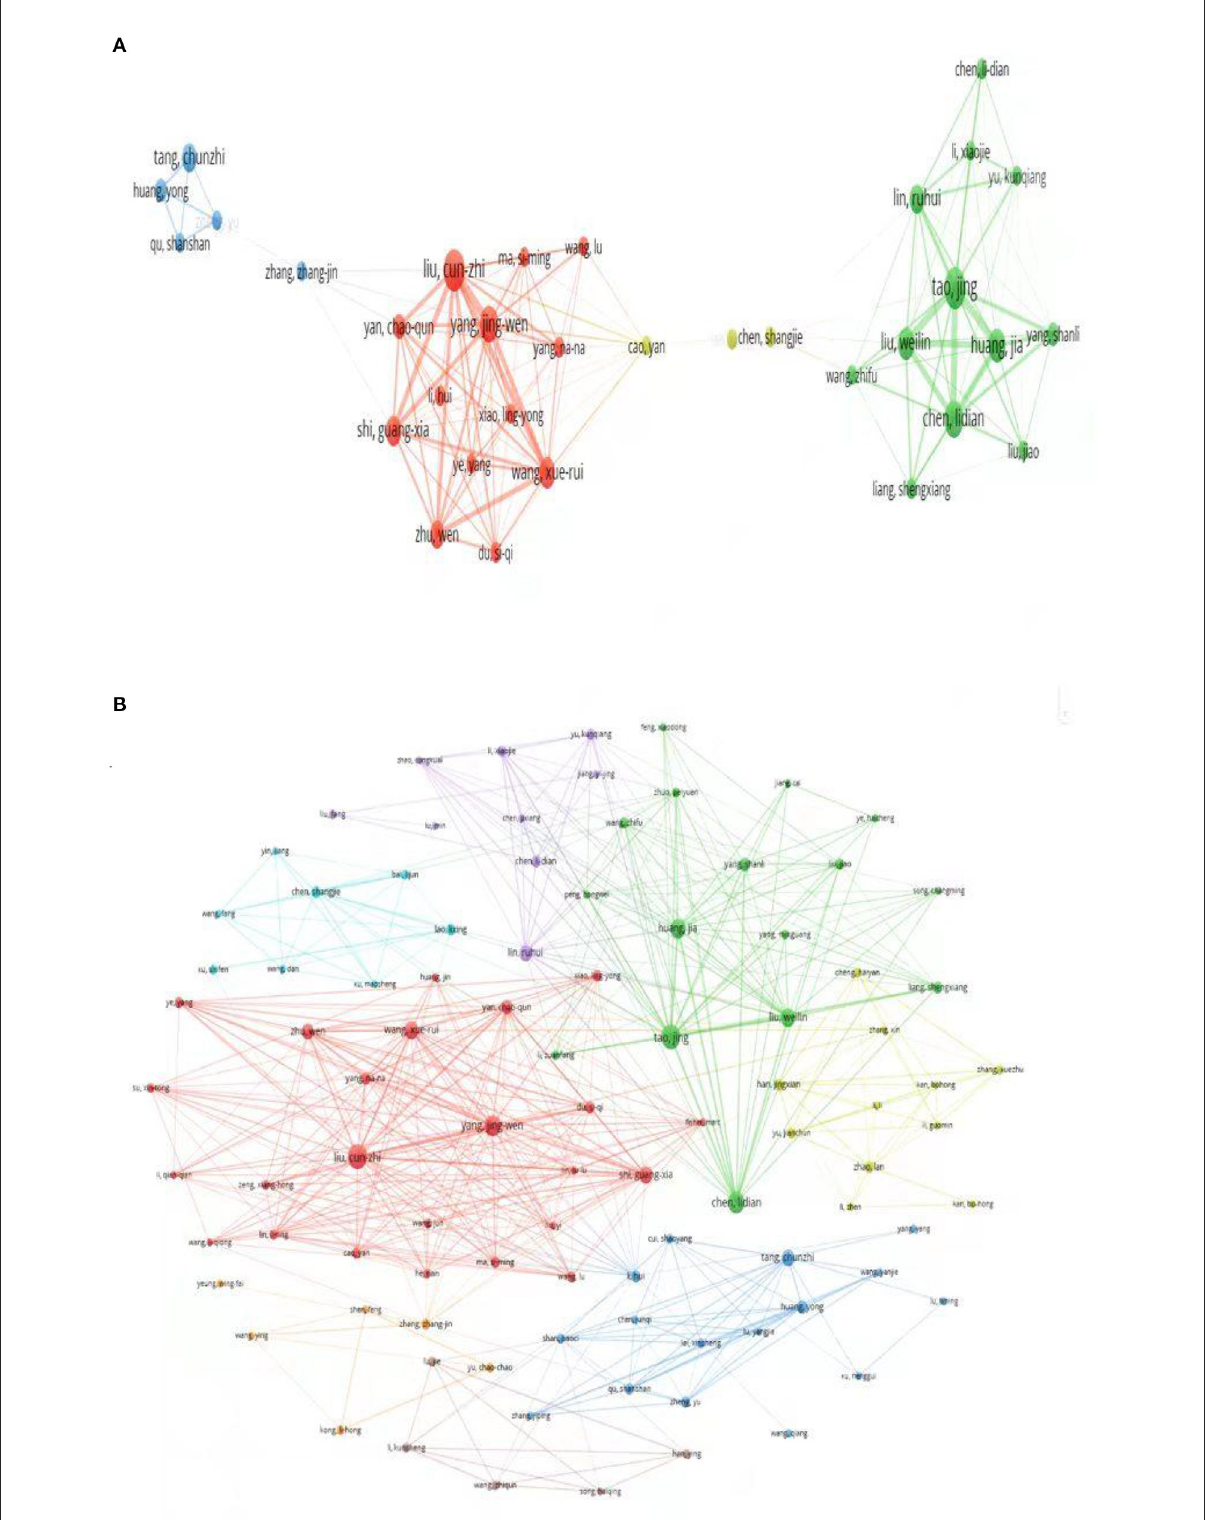
FIGURE7 Author cooperation network analysis. (A) Co-authorship network map among authors with more than 5 publications. (B) Co-citation network map among